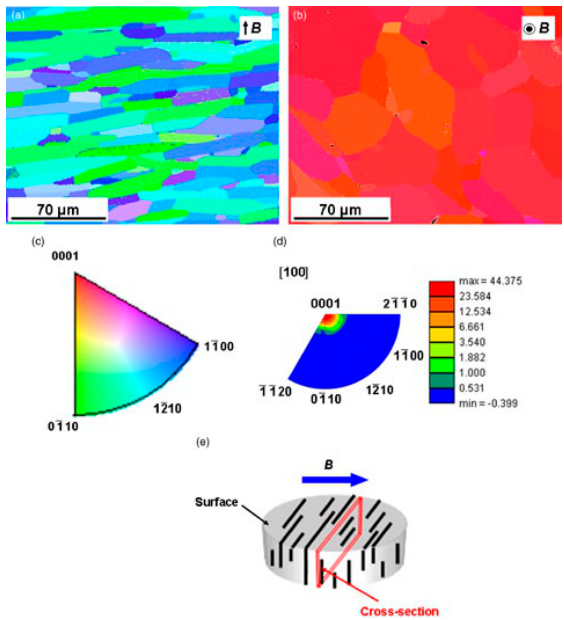
Fig. 7 Euler maps and inverse pole figure of textured α-Al 2 O 3 ceramics prepared by magnetic alignment and pressureless sintering: (a, b) Euler maps of the surface and the cross-section of textured α-Al 2 O 3 ceramics; (c) color map indicating the orientation in (a) and (b); (d) inverse pole figure for (b); (e) schematic diagram of the surface and the cross-section of textured α-Al 2 O 3